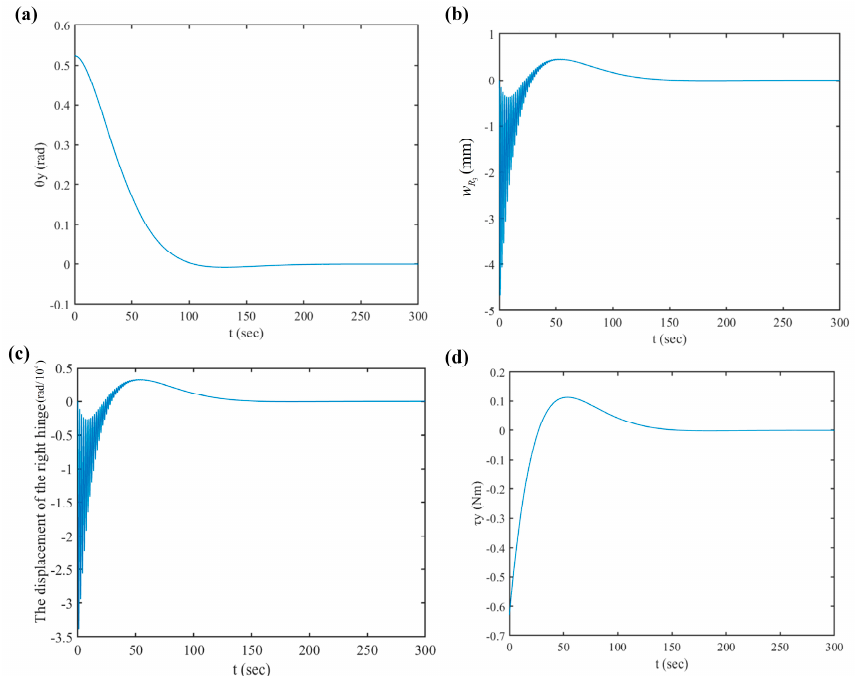
Figure 16. Time responses of the flexible spacecraft for using the PD control ( k = 500 N · m/rad); they are listed as: ( a ) the displacement of θ y ; ( b ) the displacement of the 3rd-right panel tip; ( c ) the displacement of the right hinge B R ; ( d ) the control torque τ y 1